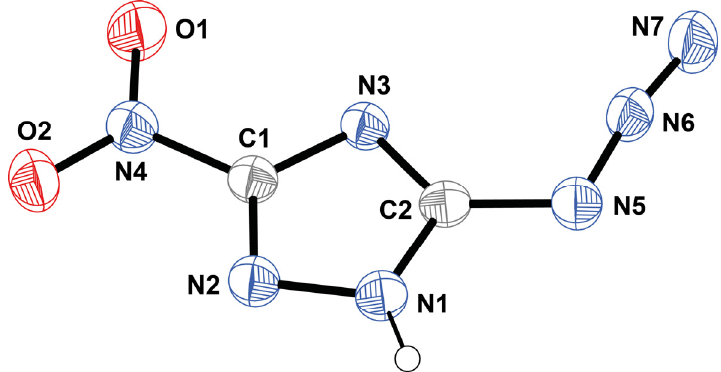
Figure 1. Molecular structure of 5-azido-3-nitro-1 H -1,2,4-triazole ( 1